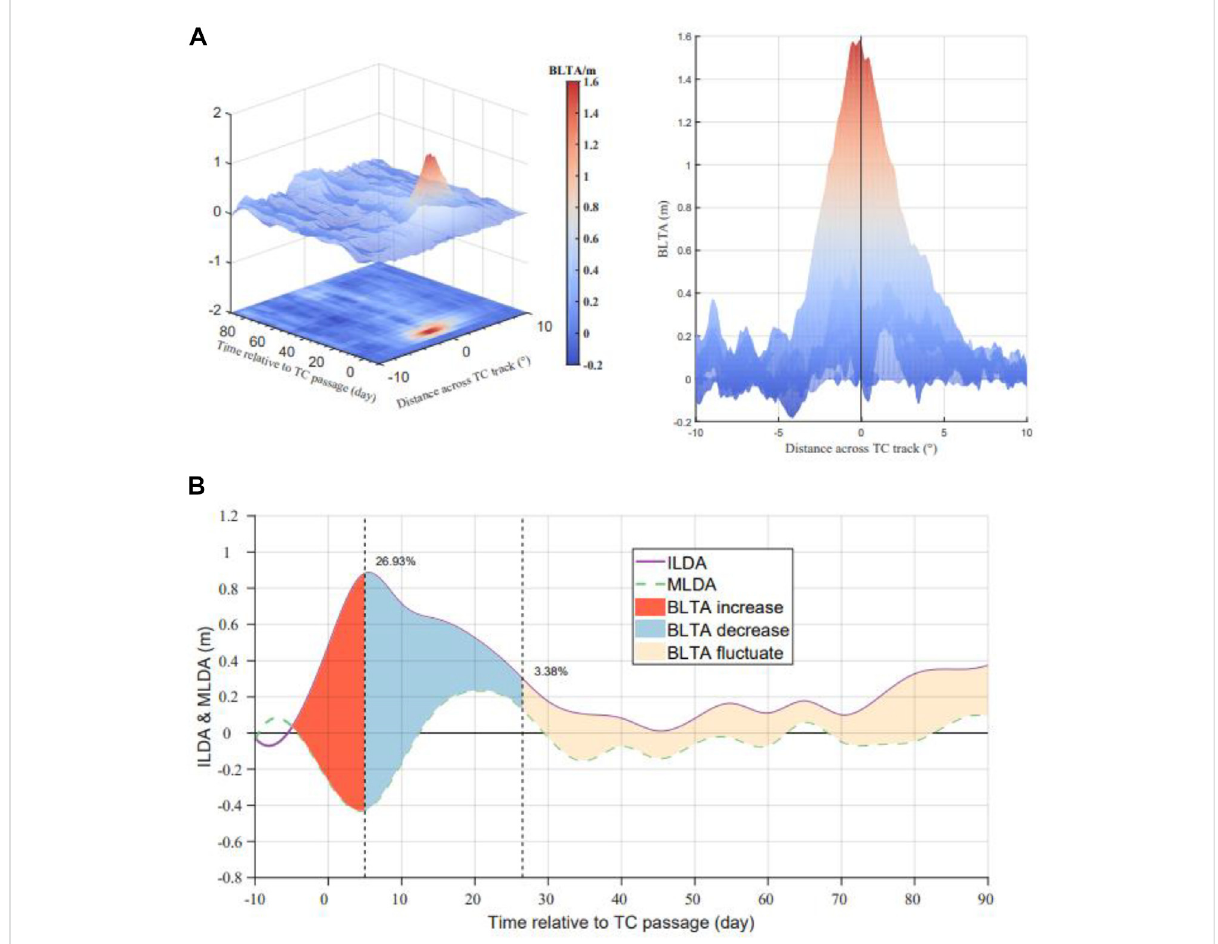
Temporal evolution of the along-track-averaged composite (A) barrier layer thickness anomaly (m) and (B) average value of BLT change within 200 km across TC track.The climatologicaltrend has been removed from the anomaliesof barrier layer thickness. The two black-dashed lines in (B) denote the largest and smallest proportion of barrier layer thickness anomaly (BLTA) before TC came respectively. Different colored areas in (B) represent different stages in which barrier layer thickness changes. The purple line represents the change of isothermal layer anomaly (ILDA). The green dashed line denotes the evolution of mixed layer anomaly